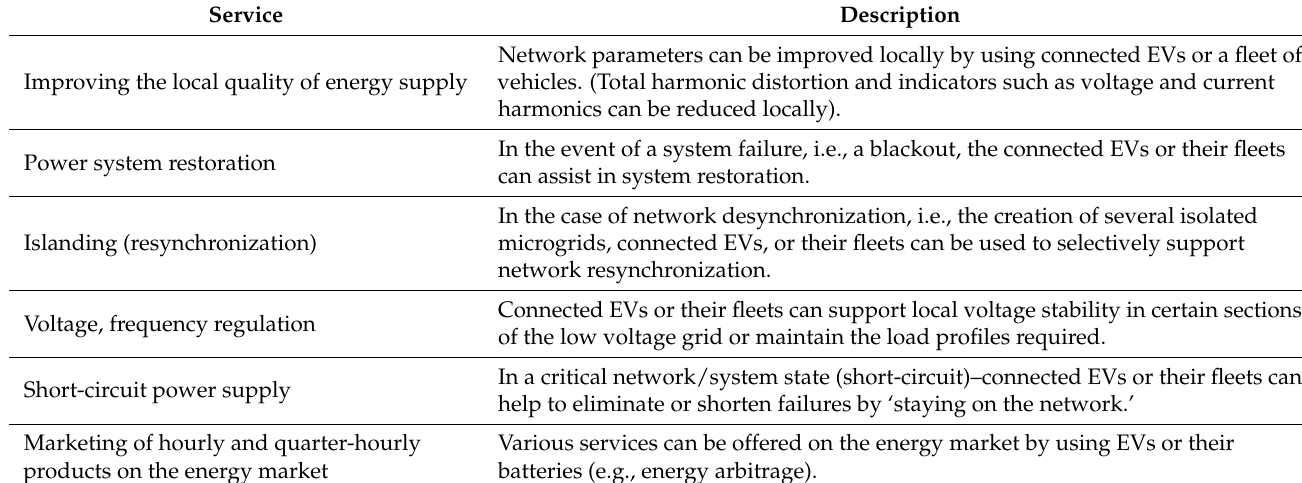
Figure 2. Histogram representing the level of consumption for particular charging events. Table 2. Summary of system services provided in the power